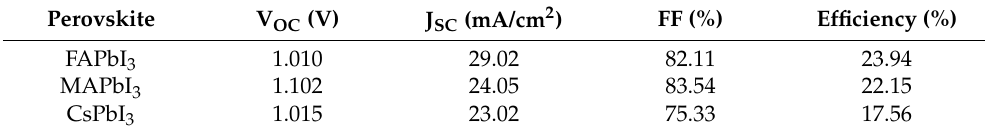
Figure 7. ( a ) J-V curves of the planar solar cells made of different perovskites as AL. ( b ) Energy level diagram of FAPbI 3 , MAPbI 3 , and CsPbI 3 . ( c ) EQE and ( d ) absorption diagrams of solar cells with different types of perovskite layers, respectively. Table 5. Effects of perovskite materials on the figures of merit of studied solar